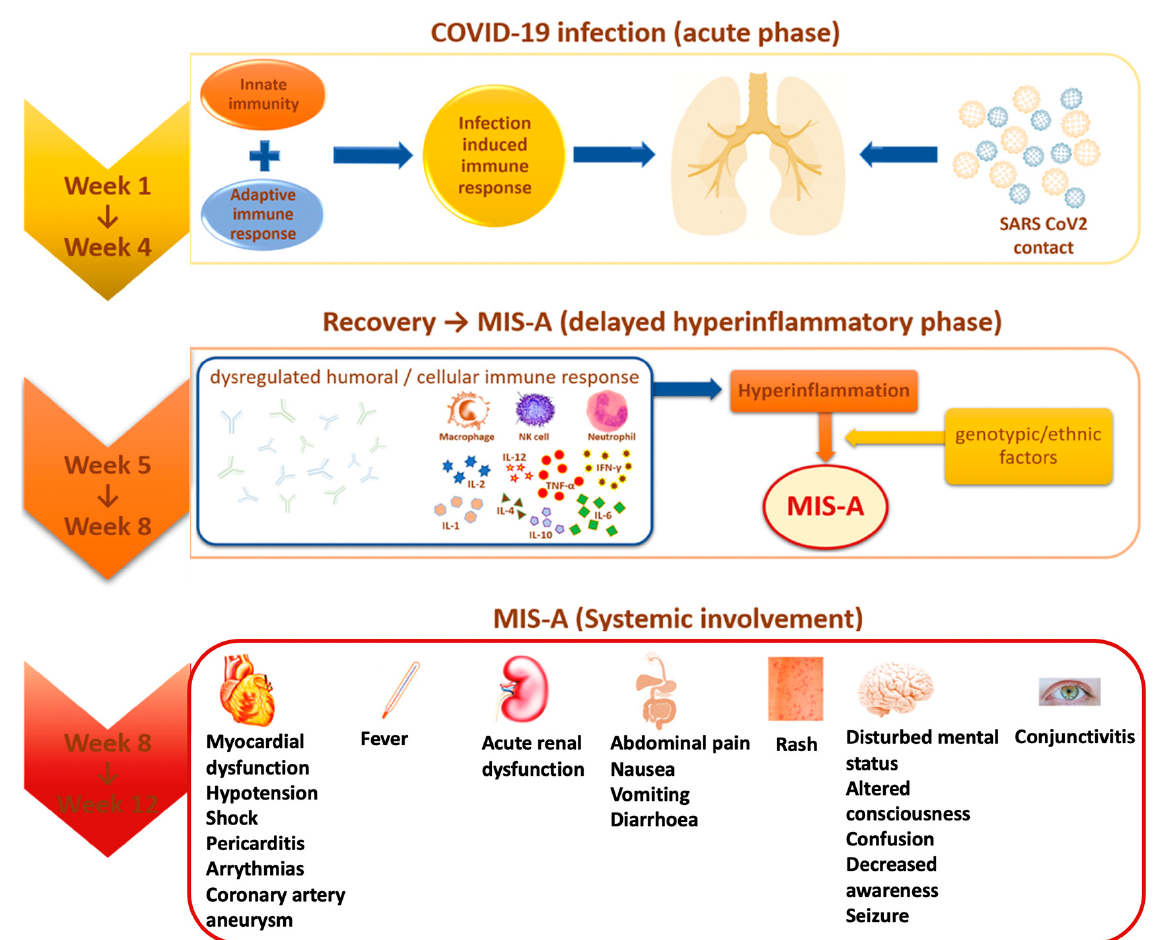
Figure 1. MIS-A evolution and systemic involvement.